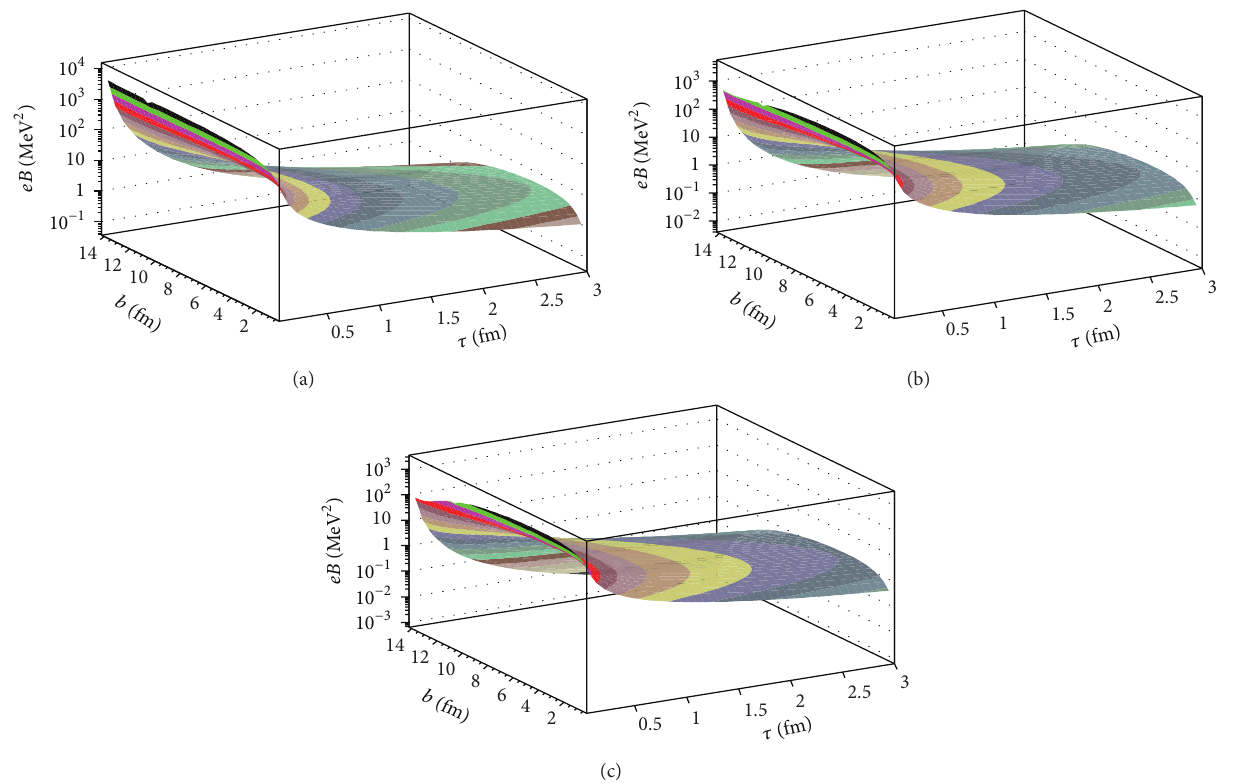
Figure 3: The dependencies of the magnetic field on proper time and impact parameters for Pb-Pb collisions at LHC collision energies with √𝑠 = 900 GeV (a), √𝑠 = 2760 GeV (b), and √𝑠 = 7000 GeV (c), respectively.